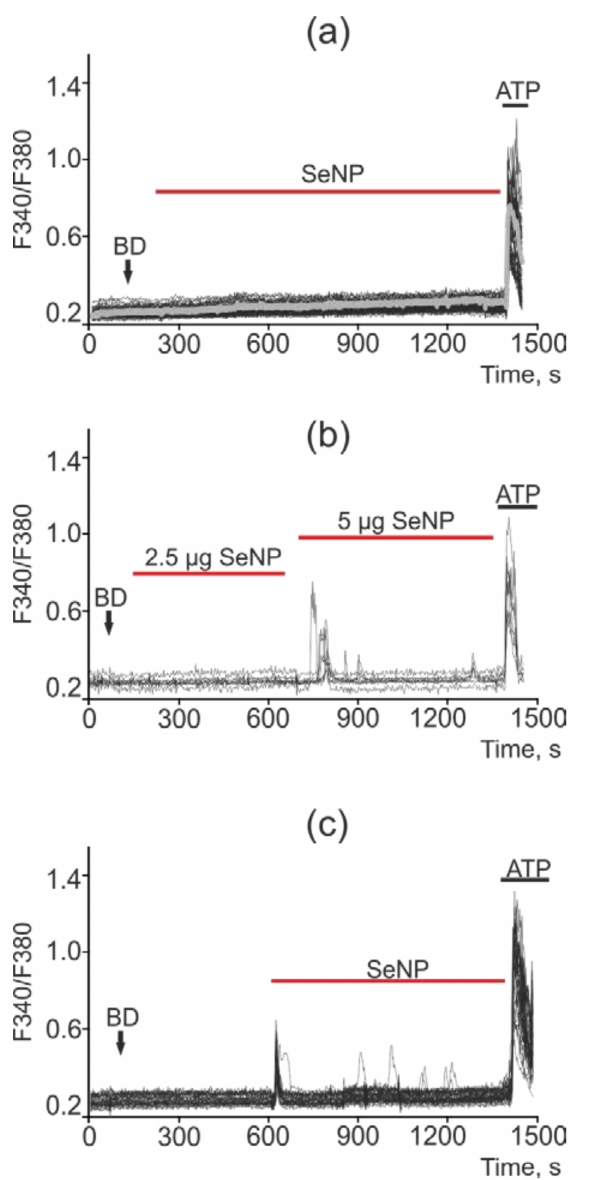
Figure 13. Ca 2+ signals in Caco-2 cells in response to application of 0.5 µ g/mL ( a ), 2.5 µ g/mL and 5 µ g/mL ( b ) and 10 µ g/mL ( c ) SeNP. BD = application of bi-distilled water equivalent to the amount of SeNP solvent. At the end of the experiment, the Ca 2+ ionophore, Ionomycin (Iono, 1 µ M), or the purinoreceptor activator, ATP (10 µ M), was applied to normalize the [Ca 2+ ]i signal to the maximum. Typical Ca 2+ signals of cells are